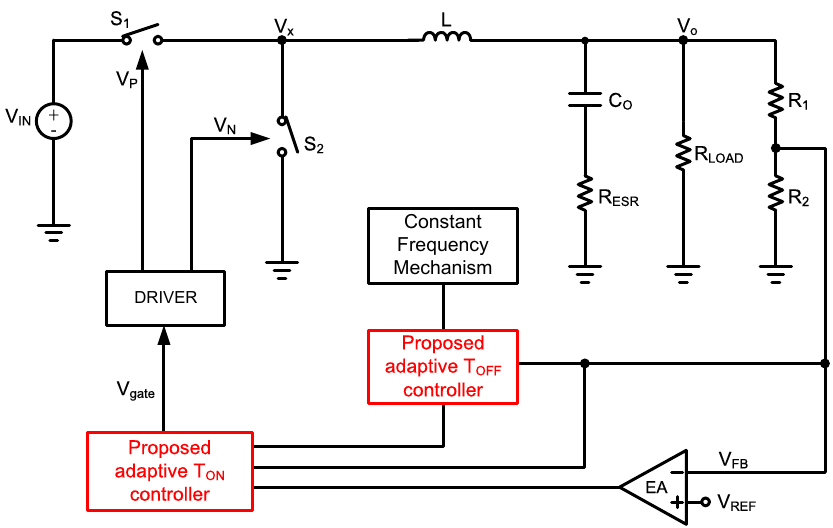
Figure 2. Control topology of the proposed converter.